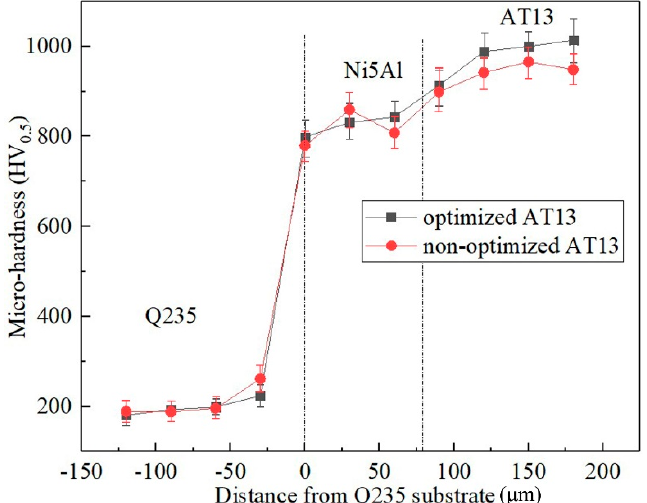
Figure 9. Microhardness distribution along cross-section of the samples prepared at nonoptimized and optimized parameters.